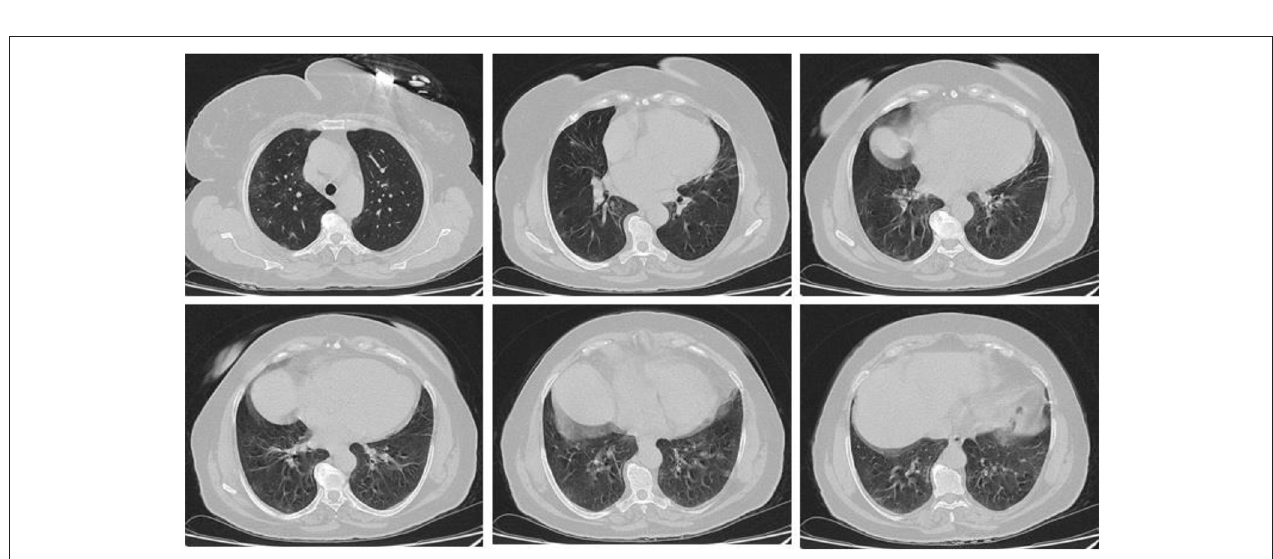
FIGURE 2 | High resolution, axial non-enhanced spiral chest CT images (lung window) of a 59-years old patient who was confirmed to be infected by COVID-19 and admitted to hospital with Flu-like symptoms and gastrointestinal tract symptoms (mostly diarrhea). CT images show multiple faint patchy consolidations disseminated in ground-glass